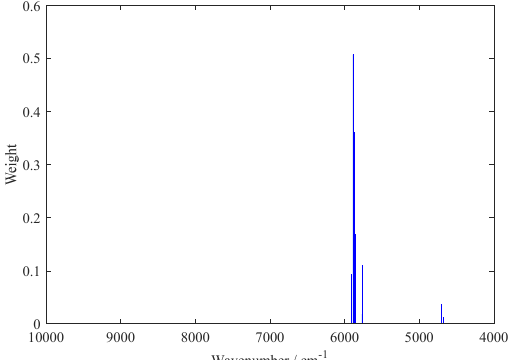
Figure 2. The weights of the variables in the optimal sub-model at the eighth iteration using the BOSS algorithm.